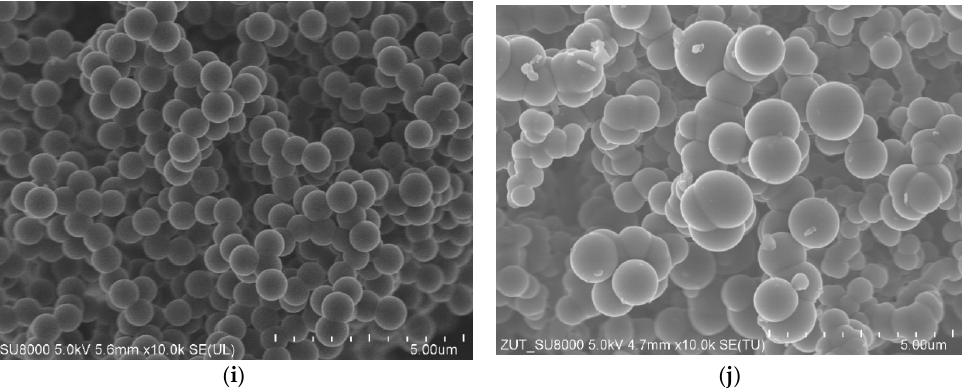
Figure 1. SEM images of the materials obtained under different experimental conditions. ( a ) ARF_15 min/120; ( b ) ARF_ 1 h/120; ( c ) ARF_ 12 h/120; ( d ) ARF_15 min/200; ( e ) ARF_1 h/200; ( f ) ARF_7/1_15 min/120; ( g ) ARF_7/1_1 h/120; ( h ) ARF_7/1_12 h/200; (i) RF; (j) RF_7/1.